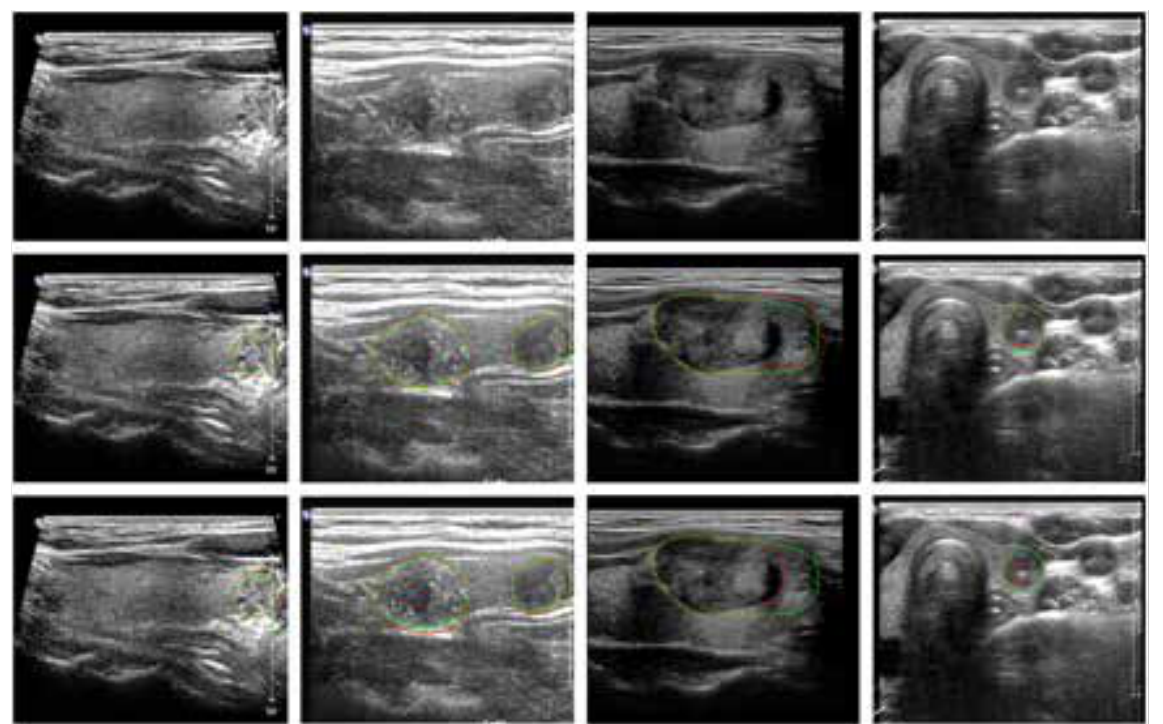
Figure 7 Segmentation cases of thyroid nodule images by the pre-trained convolutional neural network (PCNN) and convolutional neural network without pre-training (NCNN), respectively. The original images are shown in the first row; the ground truths are green; the segmentation results of the PCNN and NCNN are red shown in the second row and in the third row, respectively.